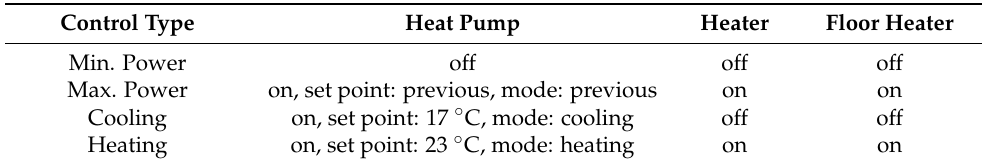
Table 1. Flexible device status after applying different control actions.